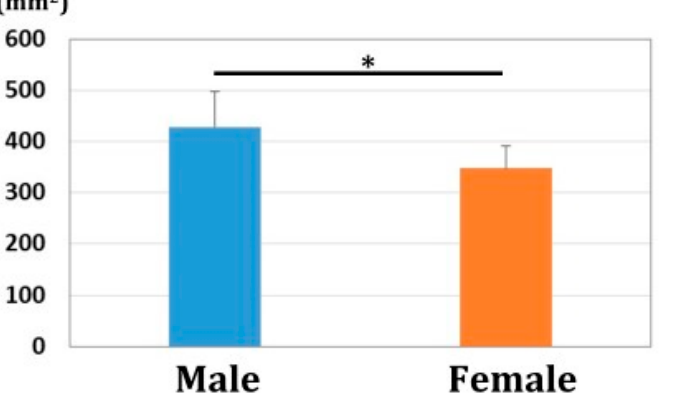
Figure 6. 3DRI and 3DPT. Both 3DRI and 3DPT were significantly larger in females than in males (*: p < 0.01).